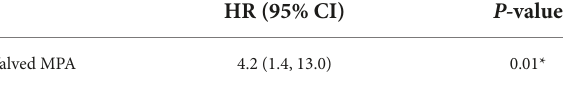
FIGURE4 Kaplan–Meier analysis of freedom from right ventricular outflow tract (RVOT)-related reintervention of subgroups (valved and non-valved).